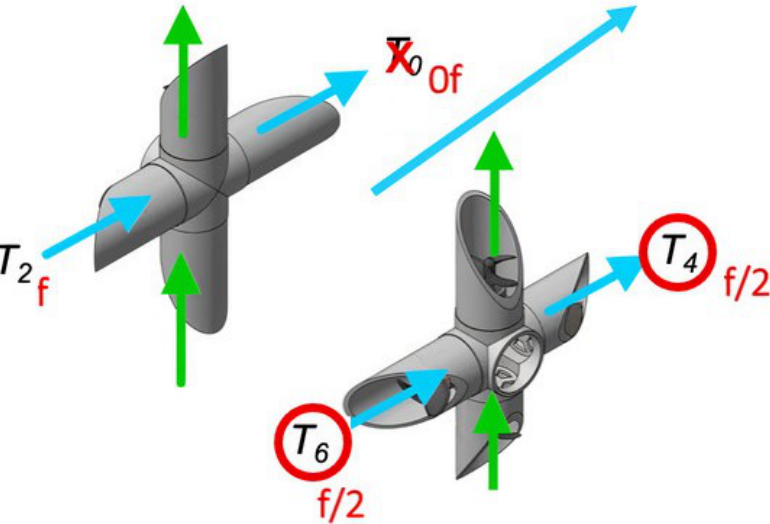
Figure 8. Force allocation in thrusters T 0 , T 2 , T 4 , T 6 when